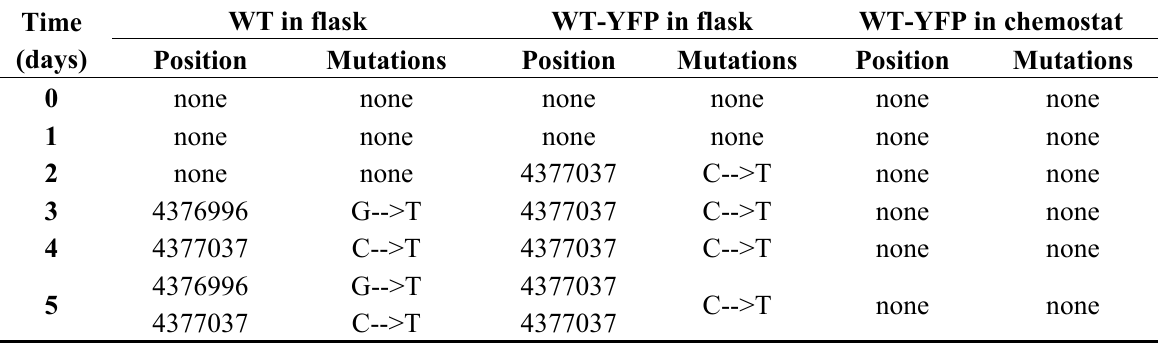
Table 1. Mutations in the promoter region of the E. coli ampC lactamase gene. Mutations in the promoter region of the ampC lactamase gene of WT and WT-YFP strains cultivated in flasks and WT-YFP cultivated in a chemostat vessel (see Figure 2). Each data point represents two sequenced PCR reactions from separate colonies from a plated-out stabilite sampled at the indicated day. Only in one case, Day 5 of the WT in a shaking flask, did the outcome of the two colonies differ. The strains obtained after five days are used for further experimentation and subsequently indicated as M8 and